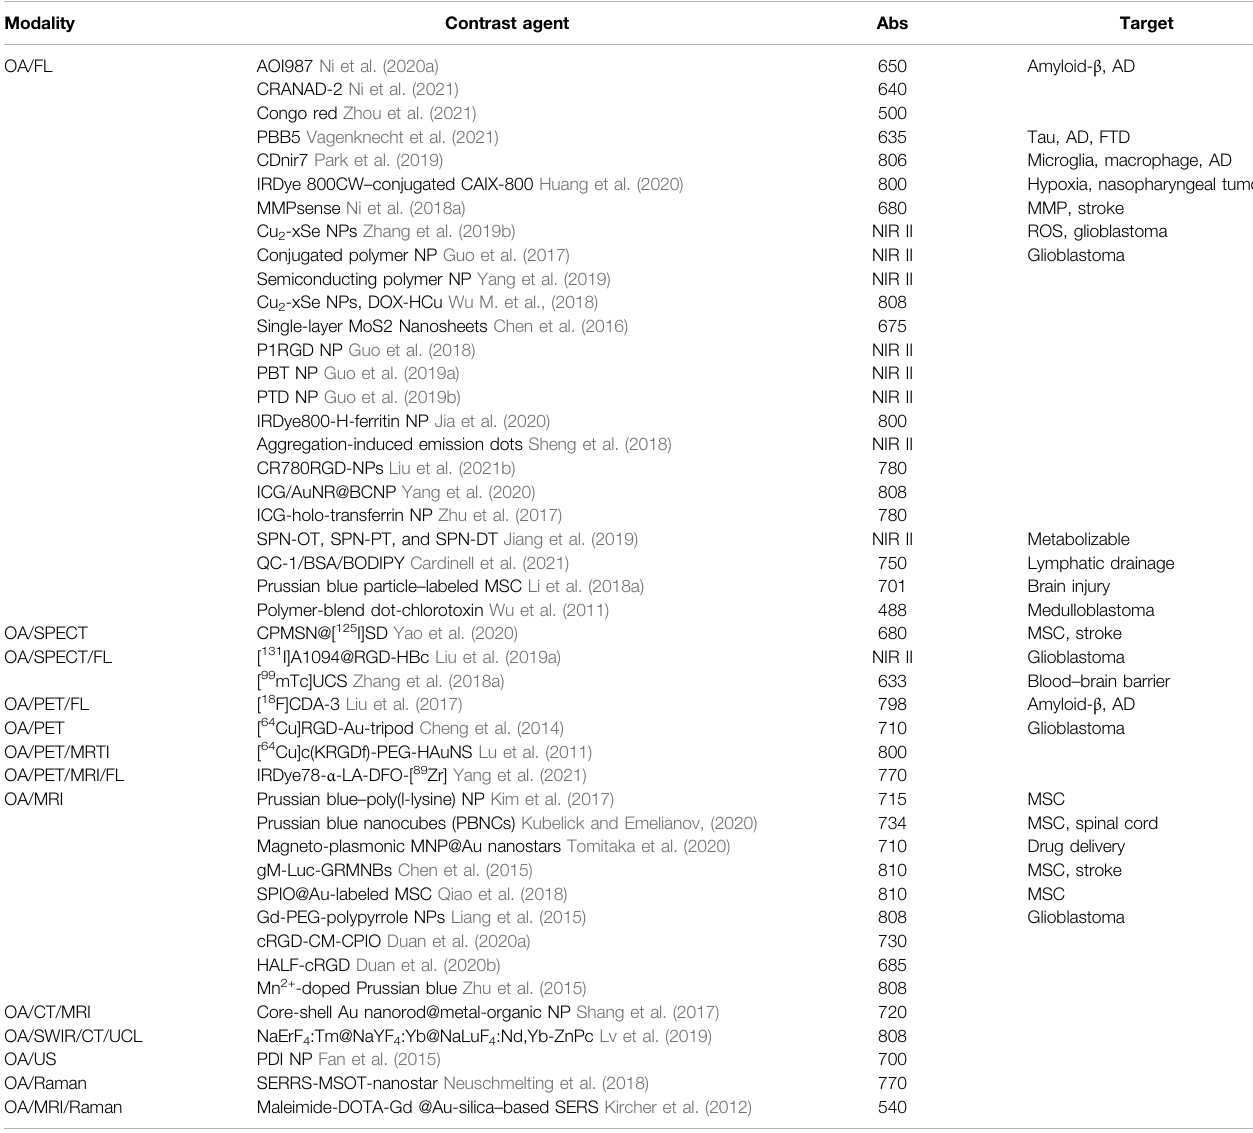
TABLE 1 | Summary of hybrid contrast agents for multimodal optoacoustic brain imaging.